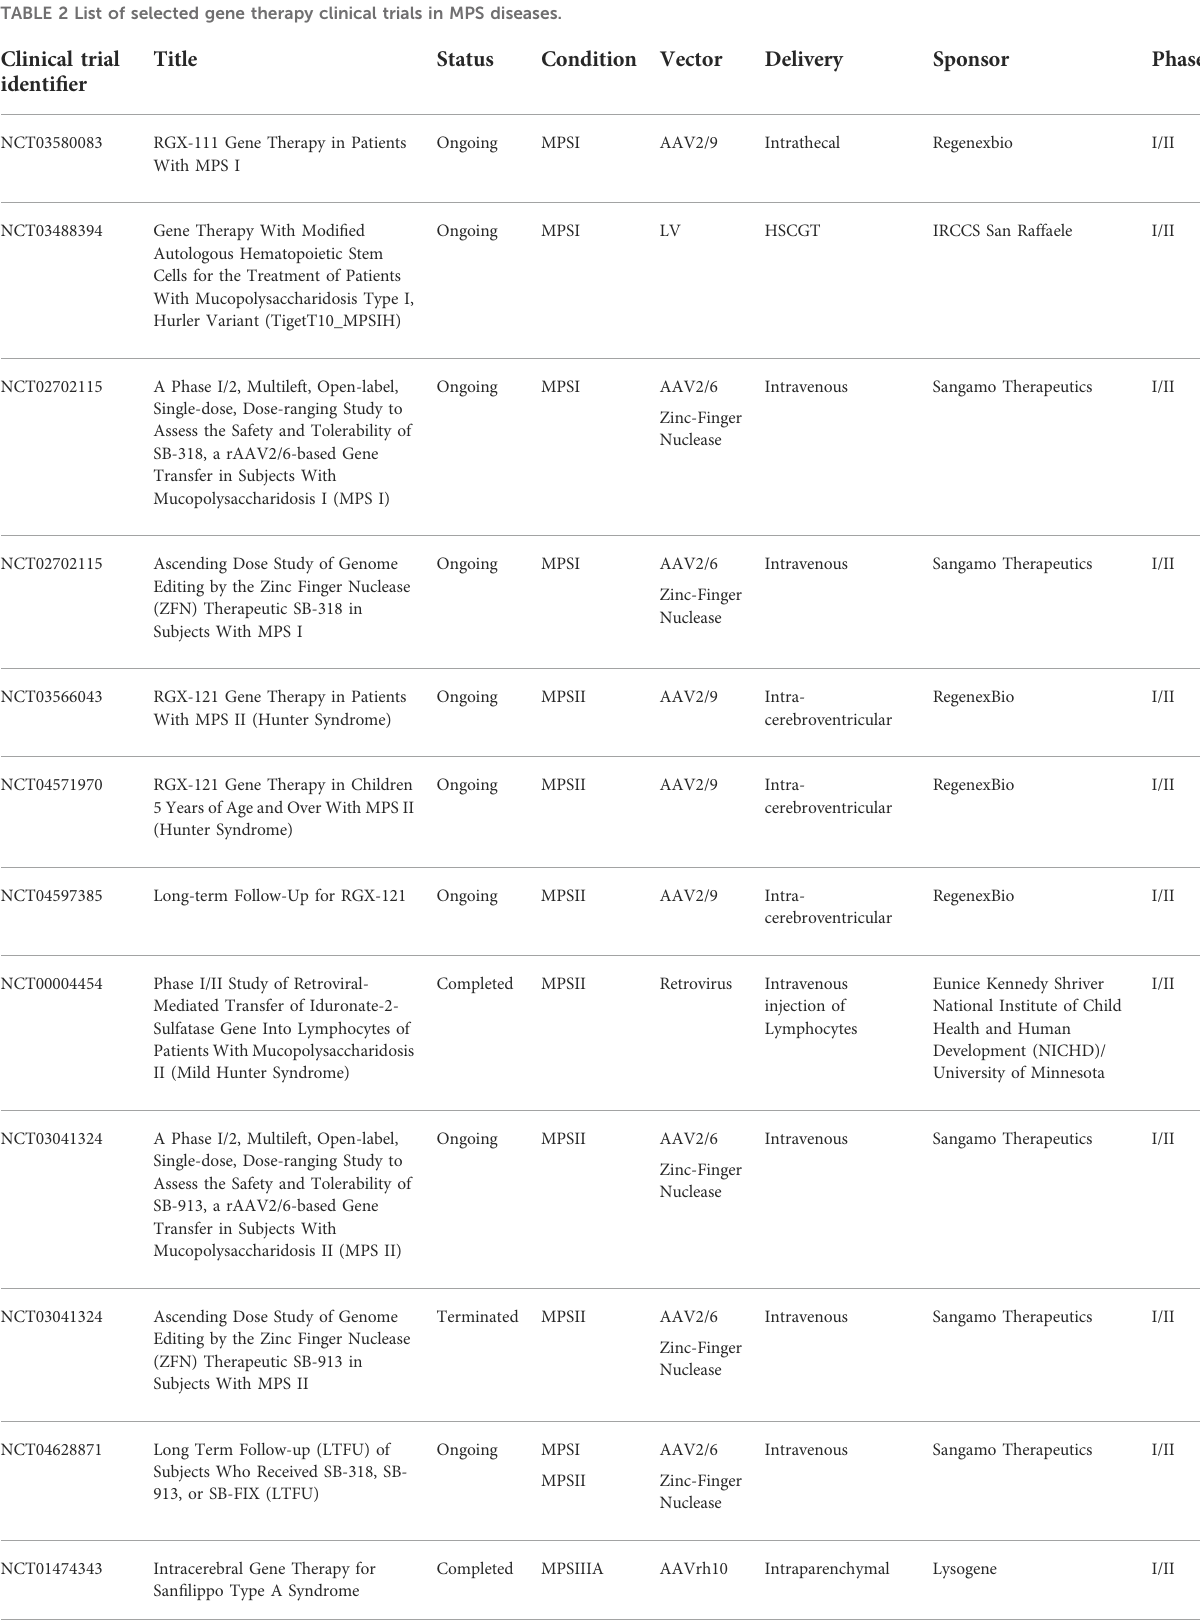
TABLE 2 List of selected gene therapy clinical trials in MPS